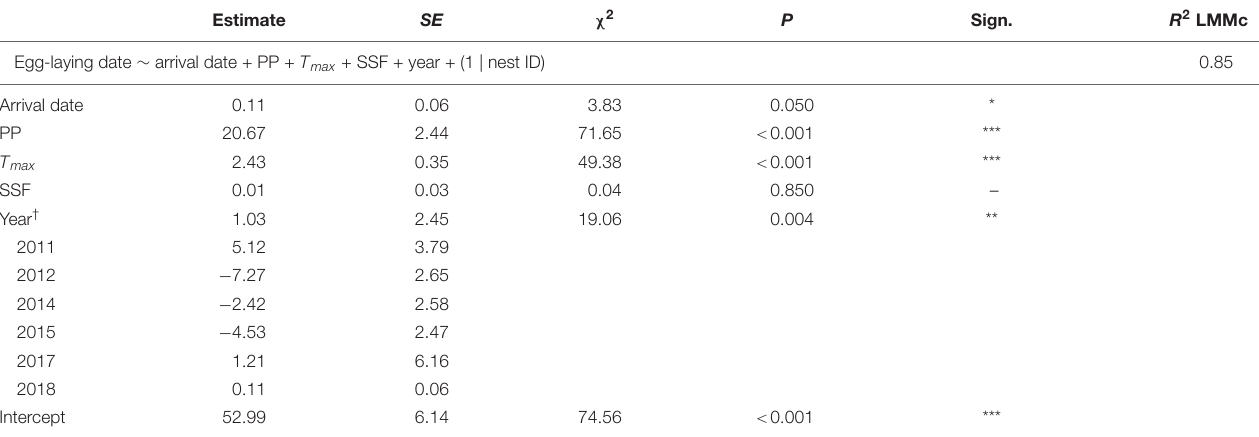
TABLE 2 | LMM on egg-laying dates from corresponding observations (2010–2012, 2014–2015, and 2017–2018) exploring the effects of arrival date, precipitation (PP, mean from 21 to 79 days before egg-laying), maximum temperature ( T max , mean from 20 to 40 days before egg-laying), Soil Seal Factor (SSF) and year.